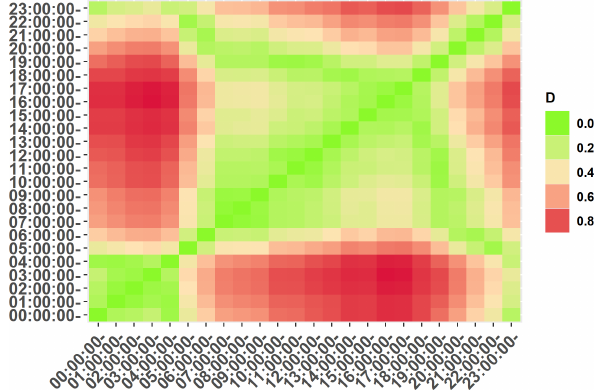
Figure 5: Values of the Kolmogorov-Smirnov test statistic for pairs of hours